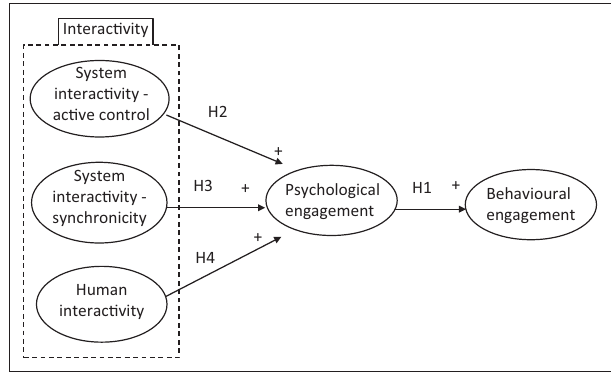
FIGURE 1: Proposed conceptual framework on the